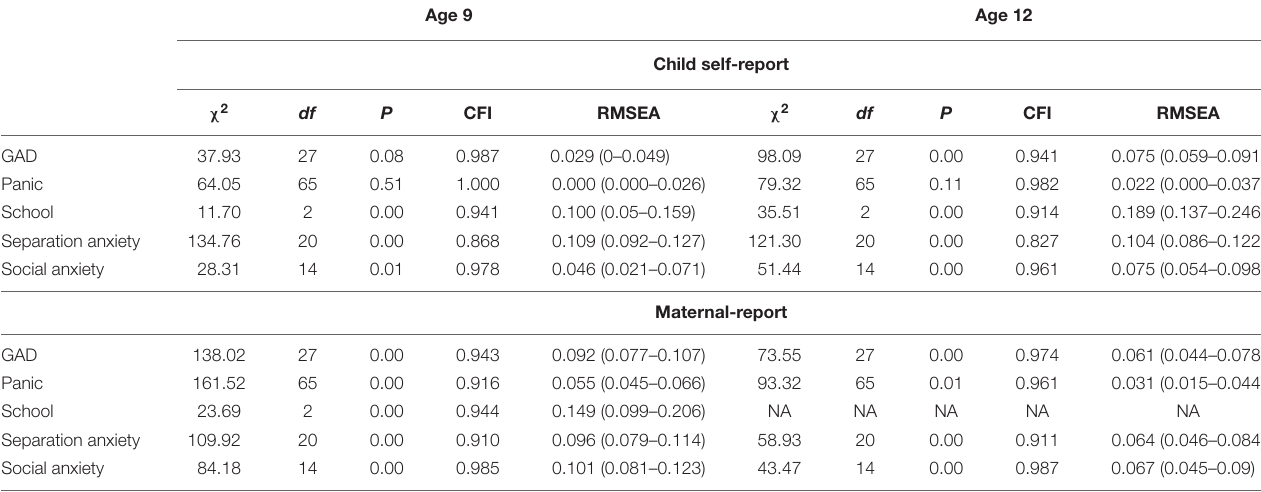
TABLE 1 | Initial model fit for child self- and maternal-report of SCARED subscales at ages 9 and 12. Age 9 Age 12